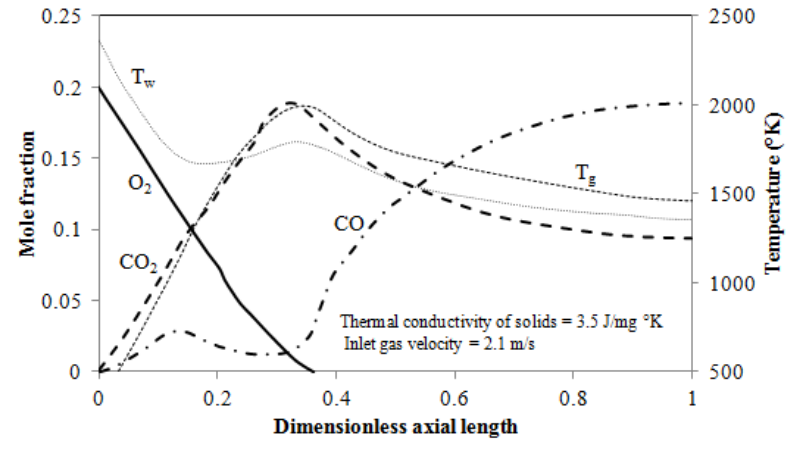
Figure 23. Typical channel temperature (gas and wall) and gas composition profiles without water influx